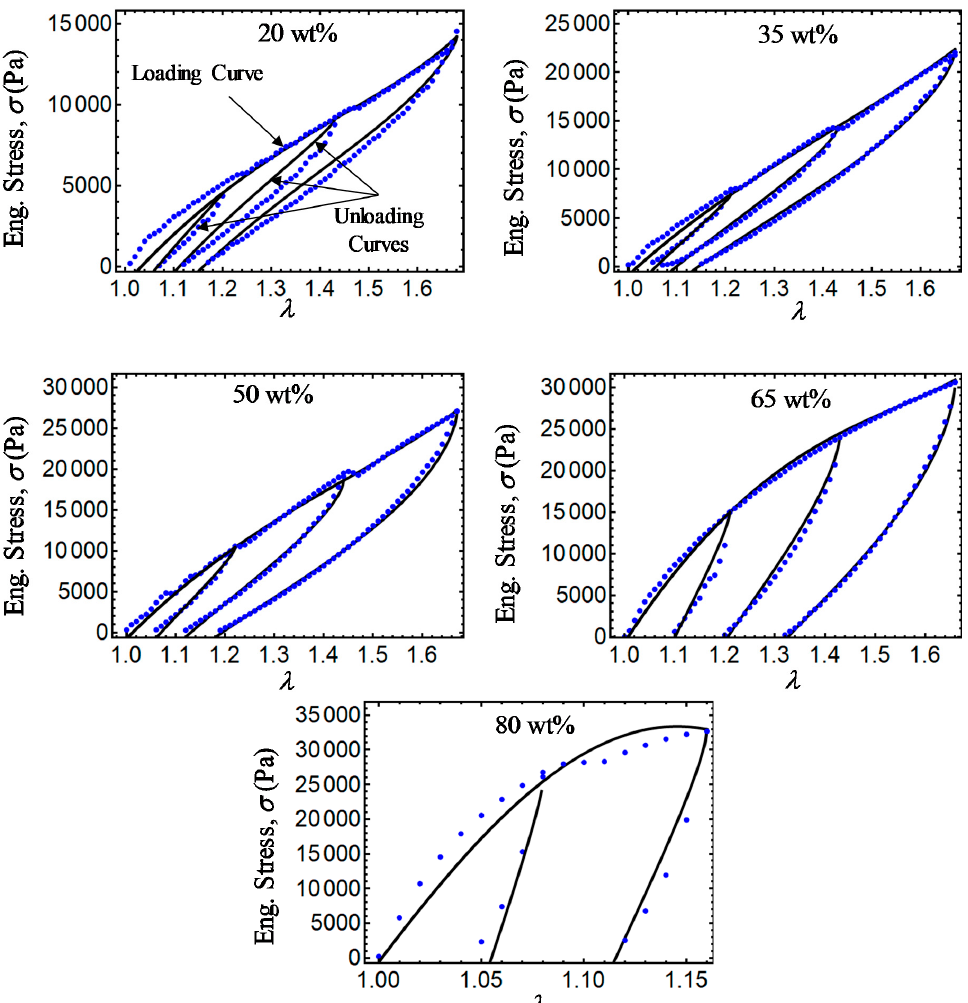
Figure 11. Engineering stress–stretch curves for isotropic magnetorheological material samples with B = 0 mT. Here, the green dots describe experimental data, while the black solid lines are theoretical predictions obtained from Equations (28) and (31).